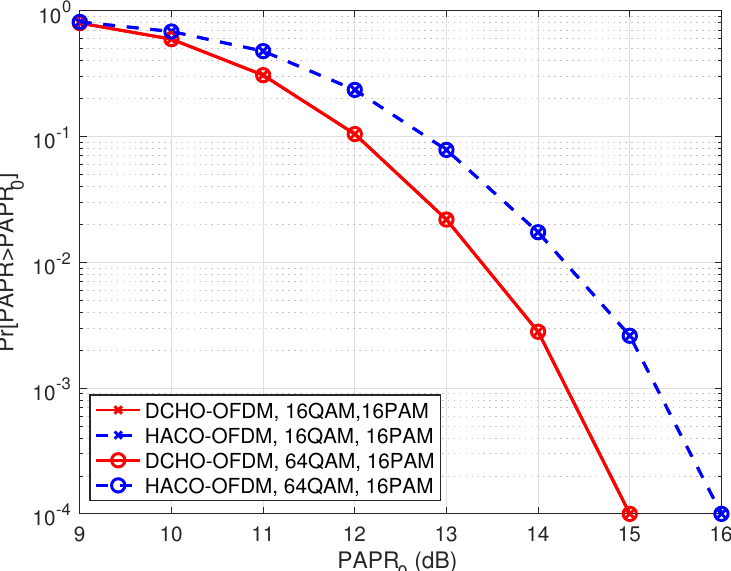
Figure 4. CCDF curves of PAPR for the proposed DCHO-OFDM scheme, compared to that of the HACO-OFDM